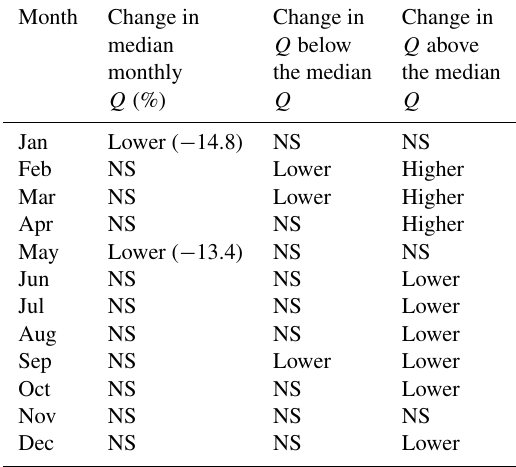
Table 3. Relative changes in monthly water yield ( Q ) for dif- ferent parts of the cumulative distribution function for the period May 1979 to April 2015 for the treated WS6 using the frequency- pairing method. “Lower” and “Higher” denote direction and signif- icance ( p < 0.05) of change; NS = not